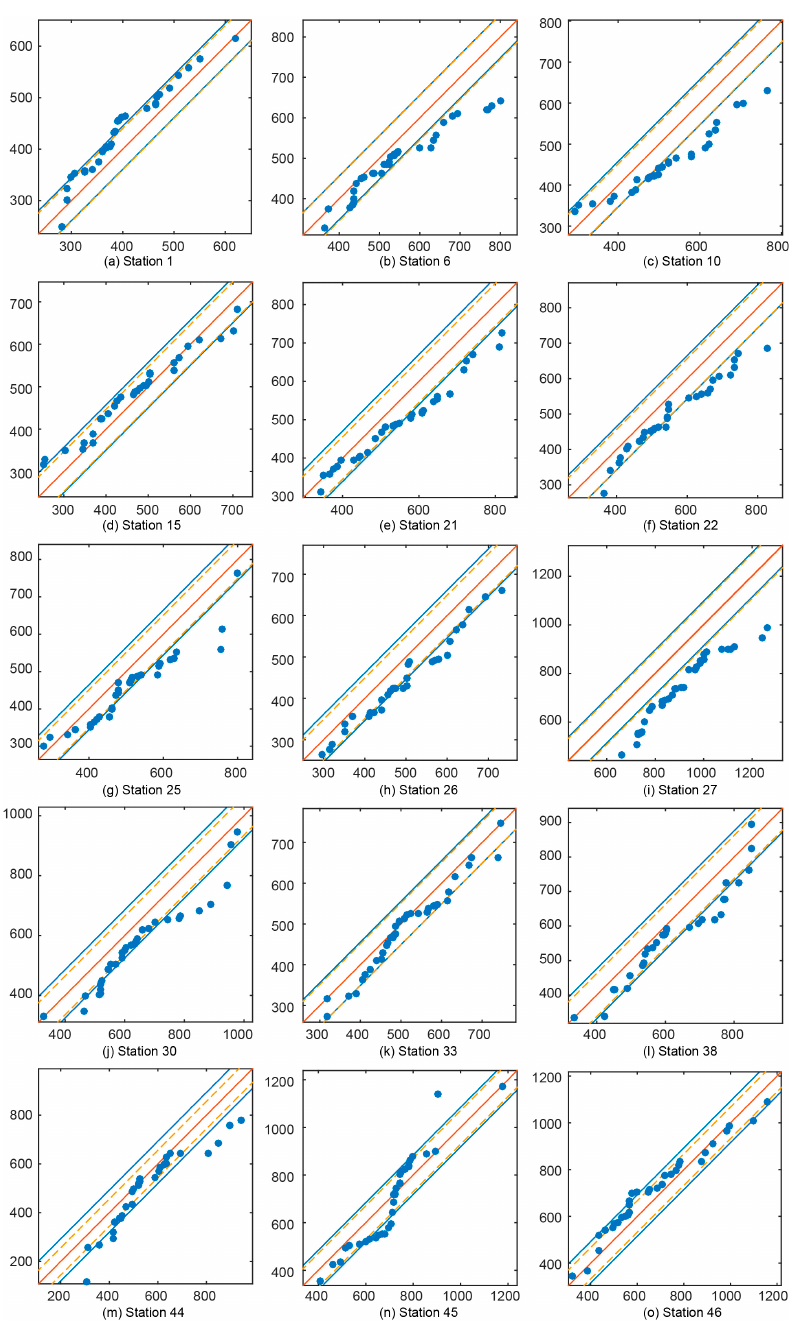
Figure 4. PTM plots for annual rainfall. The solid diagonal red line is the 1:1 line, the upper and lower dashed lines are the +10% and − 10% lines respectively, and the solid blue line is the boundary of 95% confidence intervals for the overall trend estimated by the nonparametric bootstrap procedure. (Unit: mm).